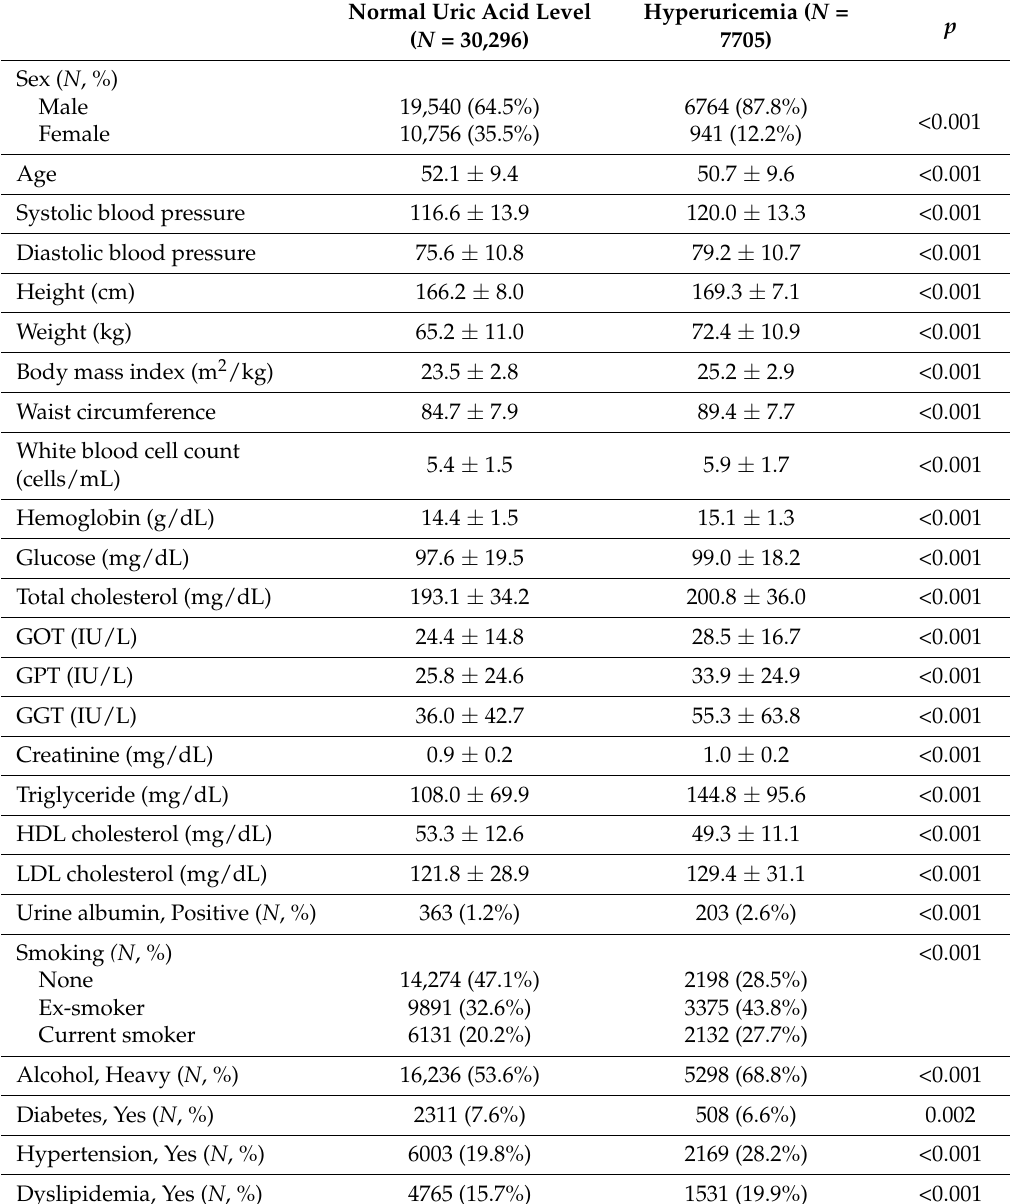
Table 3. Demographics features of the included